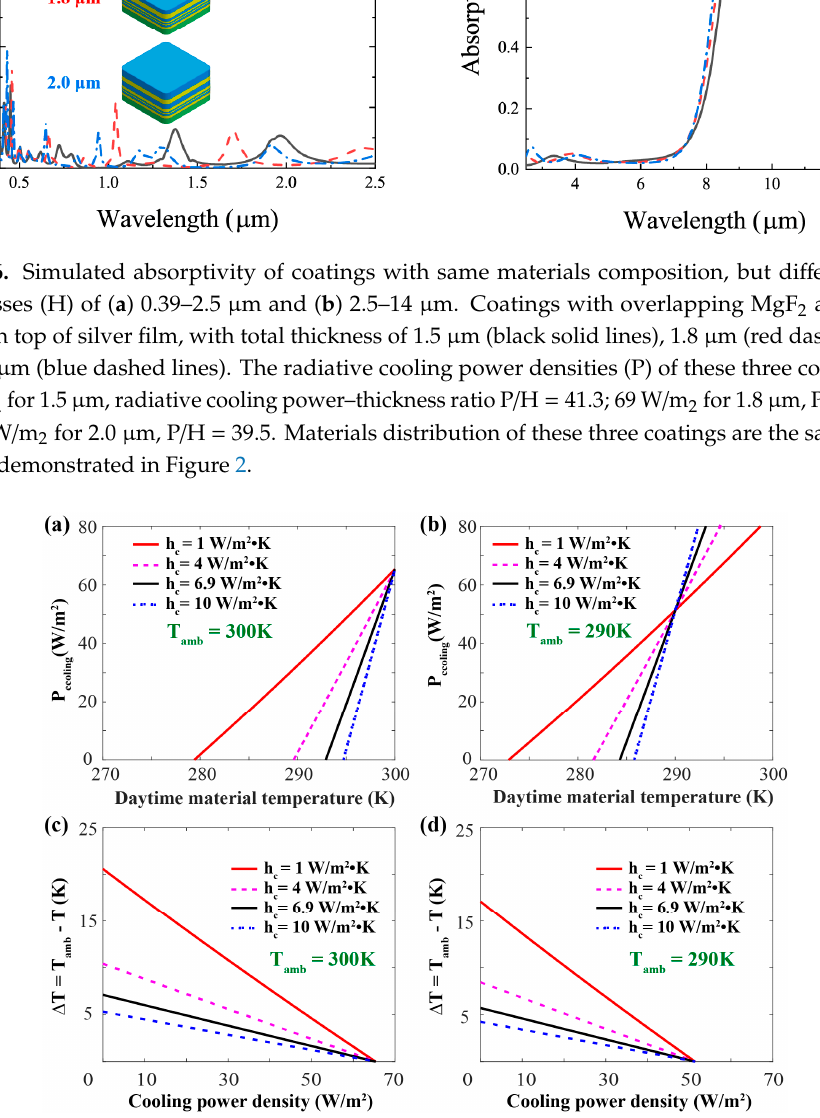
Figure 7. Numerically simulated radiative cooling performance of the structure. ( a , b ) Calculated net